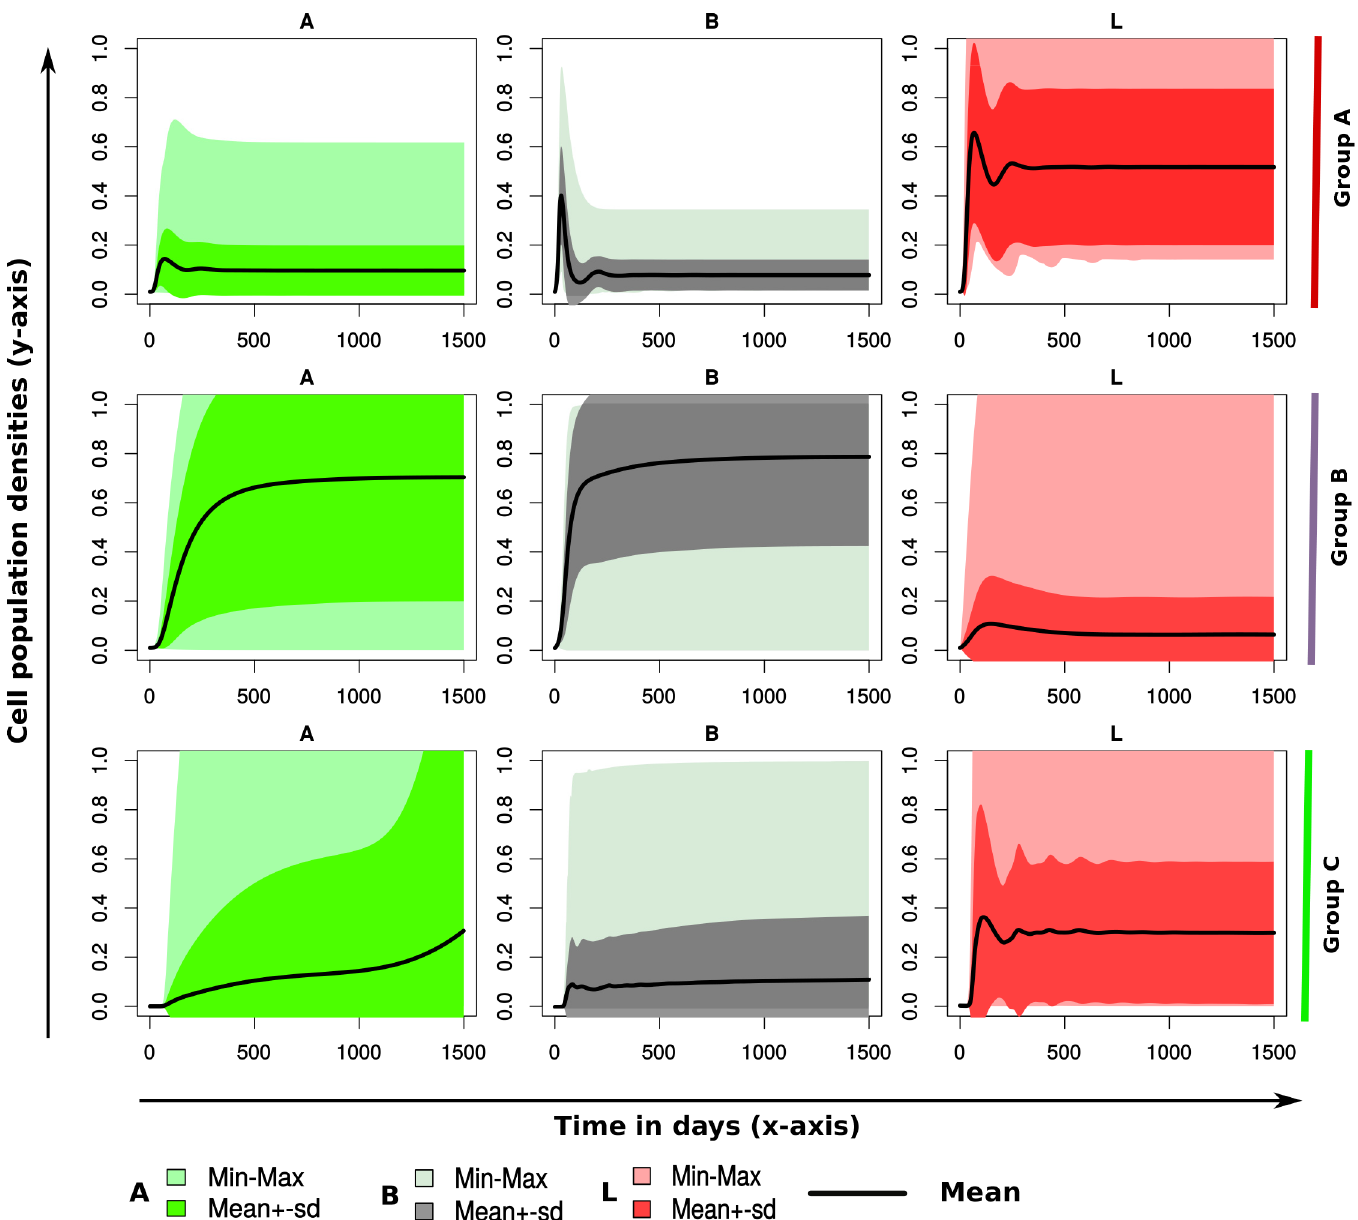
Fig 5. Group Summary Dynamics. The upper row shows trajectories of CFU shedding and immune response variables using summary parameters for Group A. The middle and lower rows show corresponding summary dynamics for Groups B and C, respectively. Summary parameter statistics for each parameter were derived by finding the average of each parameter in each group, and the uncertainty in the trajectories were generated by carrying out multivariate sensitivity analysis (using LHS method), hence generating the shaded regions, where min and max correspond to the minimum and maximum group trajectories generated and the solid line represents the group